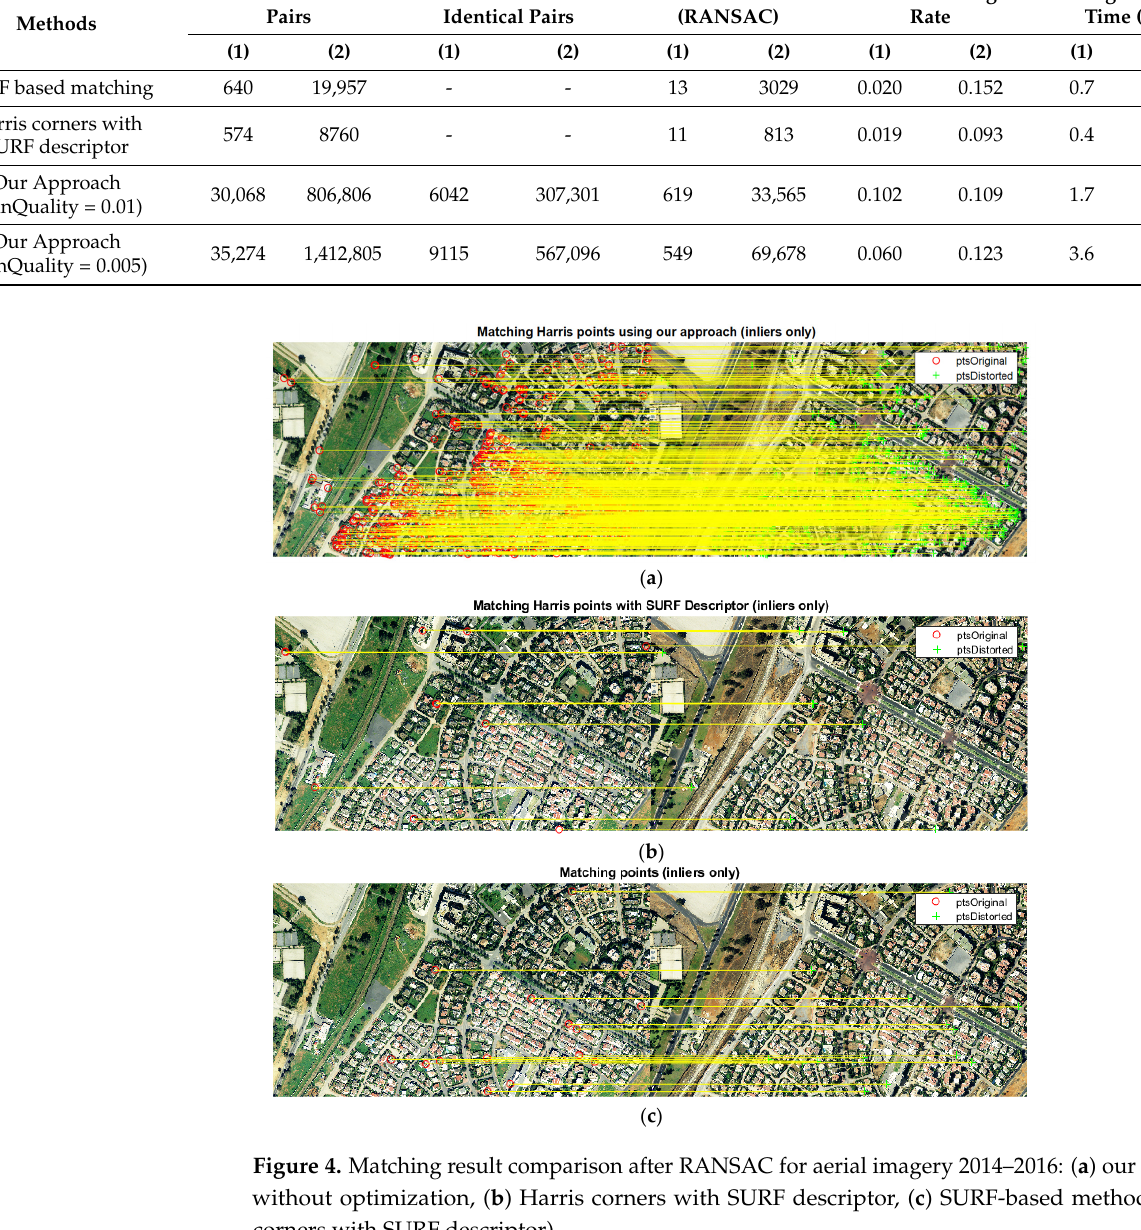
Table 5. Comparison between time consumption and true matching rate of the proposed method and SURF-based matching. (1) Aerial image 2014–2016 (45792 SURF corners and 35274 Harris corners). (2) Satellite imagery 2013–2014 (1760353 SURF corners and 1094728 Harris corners). MinQuality: Minimum accepted quality of corners.